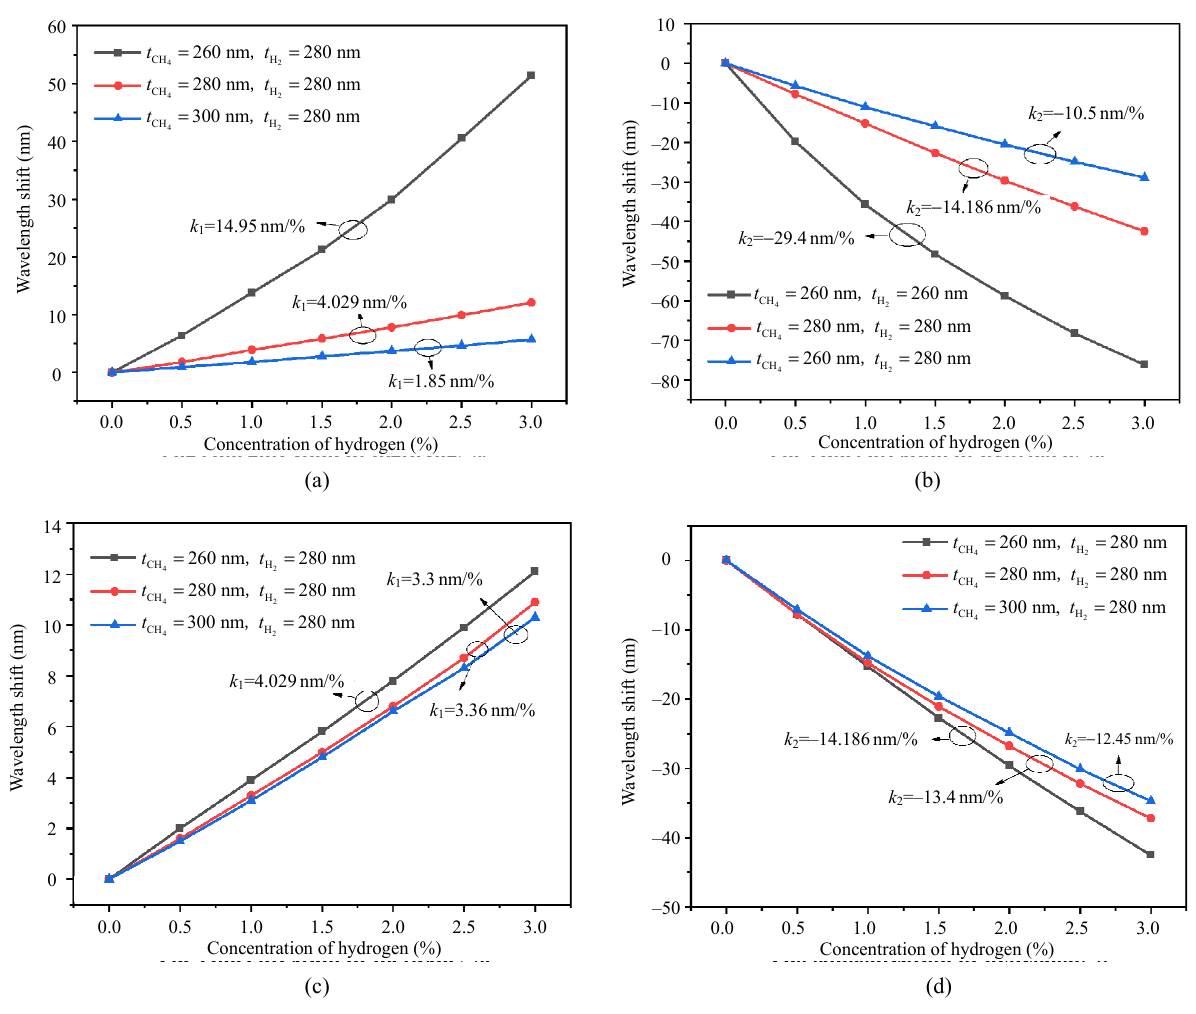
Fig. 7 Specific Stokes sensitivities vary with the gas-sensitive film thicknesses: (a) Stokes methane sensitivity curves and (b) Stokes hydrogen sensitivity curves with the thickness of the hydrogen gas-sensitive film; (c) Stokes methane sensitivity curves and (d) Stokes hydrogen sensitivity curves with the thickness of the methane gas-sensitive film. Table 1 Influence of the gas-sensitive film thickness on